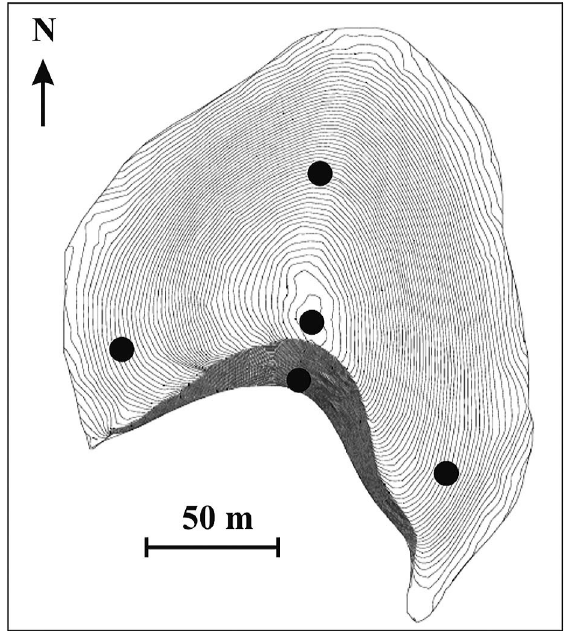
Fig. 1. The location of sample points (on the example of a dune near Laâyoune) (dune elevation model by Katarzyna